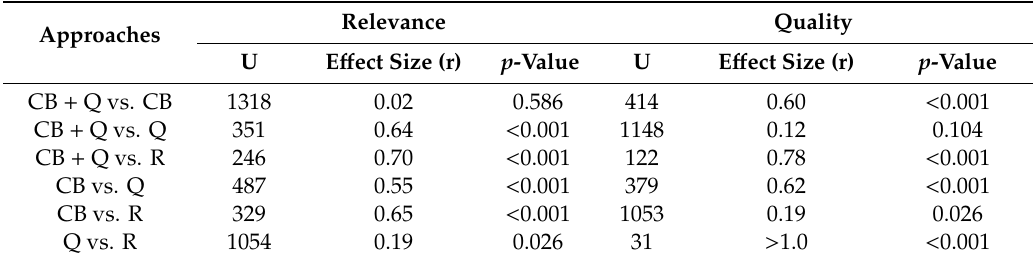
Table 2. Results of Mann-Whitney U tests comparing relevance and quality